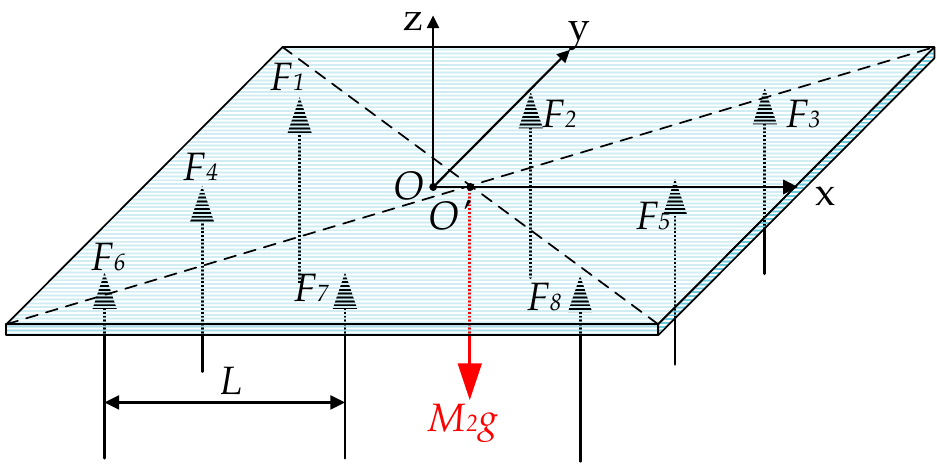
Figure 5. Forces analysis of the plate in z ‐ axis direction.